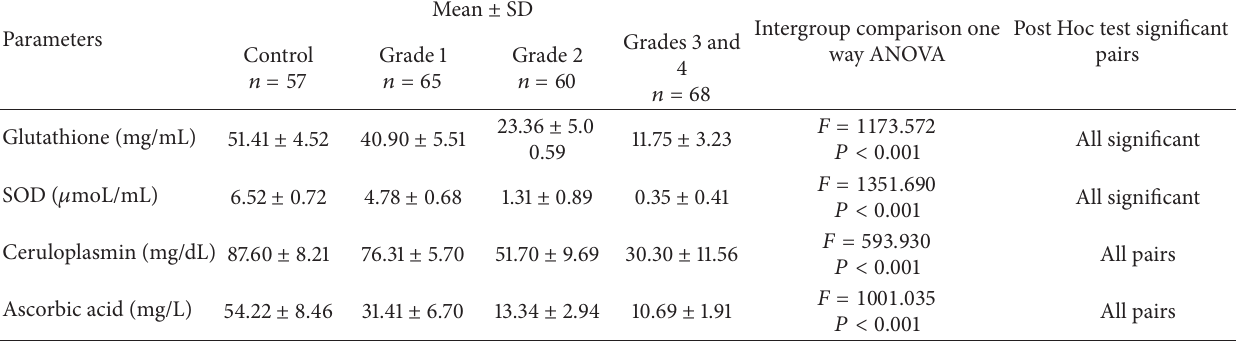
Table 3: Serum antioxidants in cases of malnutrition and control.